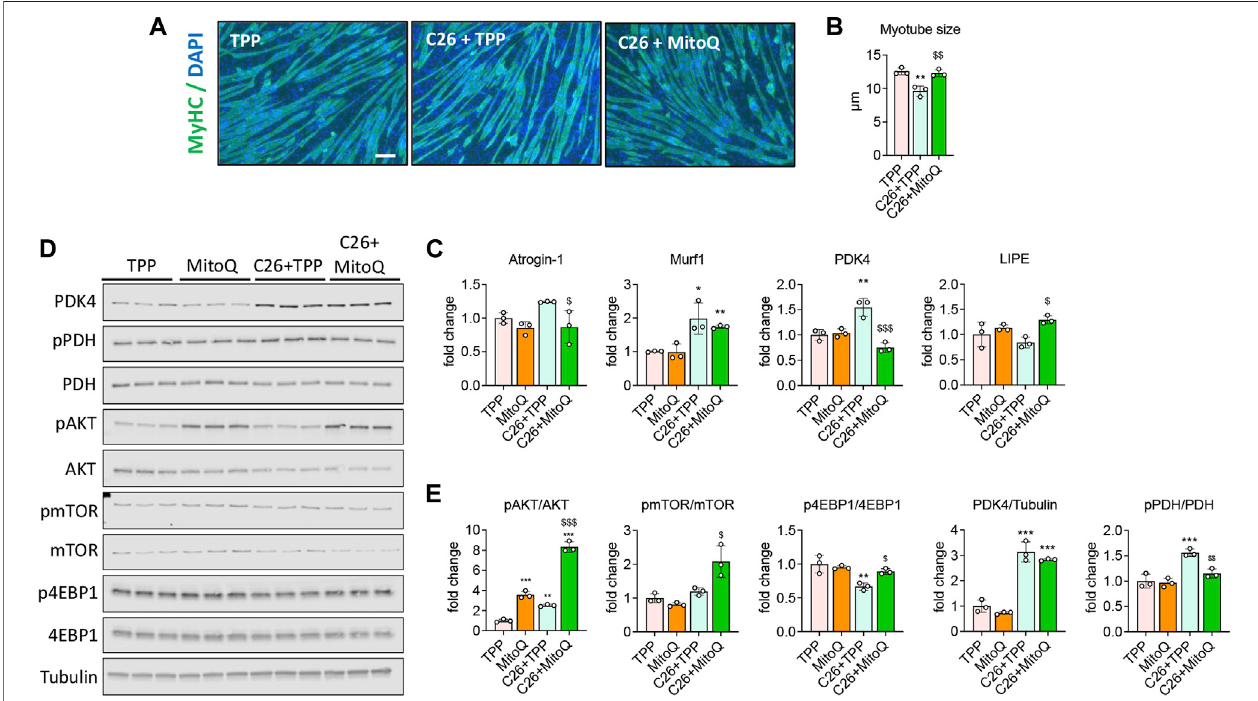
FIGURE 1 | MitoQ improves myotube atrophy and in vitro metabolism. (A,B) Myosin heavy chain (MyHC; green) and DAPI (blue) immuno fl uorescent staining in C2C12 myotubes exposed to unconditioned medium or 20% C26 CM (C26) and treated with 75 µM MitoQ or TPP for up to 48 h. Myotube size was determined by measuring the minimum diameter of 250 – 350 myotubes per experimental condition ( n = 3). Scale bar, 100 μ m. (C) Gene expression levels for Atrogin-1 Murf1, PDK4 and Lipe in C2C12 myotubes. Gene expression was normalized to TBP levels and expressed as fold change vs. TPP. (D,E) Representative Western blotting and quanti fi cationforphospho-AKT(pAKT),AKT,phospho-mTOR(pmTOR),mTOR,phospho-4EBP1(p4EBP1),4EBP1,PDK4,phospho-PDH(pPDH),PDH,expressedas fold change vs. TPP. Tubulin was used as loading control. Statistical signi fi cance was evaluated by two-way analysis of variance, and signi fi cant differences (at least p < 0.05) were reported as * p < 0.05, ** p < 0.01, *** p < 0.001 vs. TPP; $ p < 0.05, $$ p < 0.01, $$$ p < 0.001 vs. C26 +